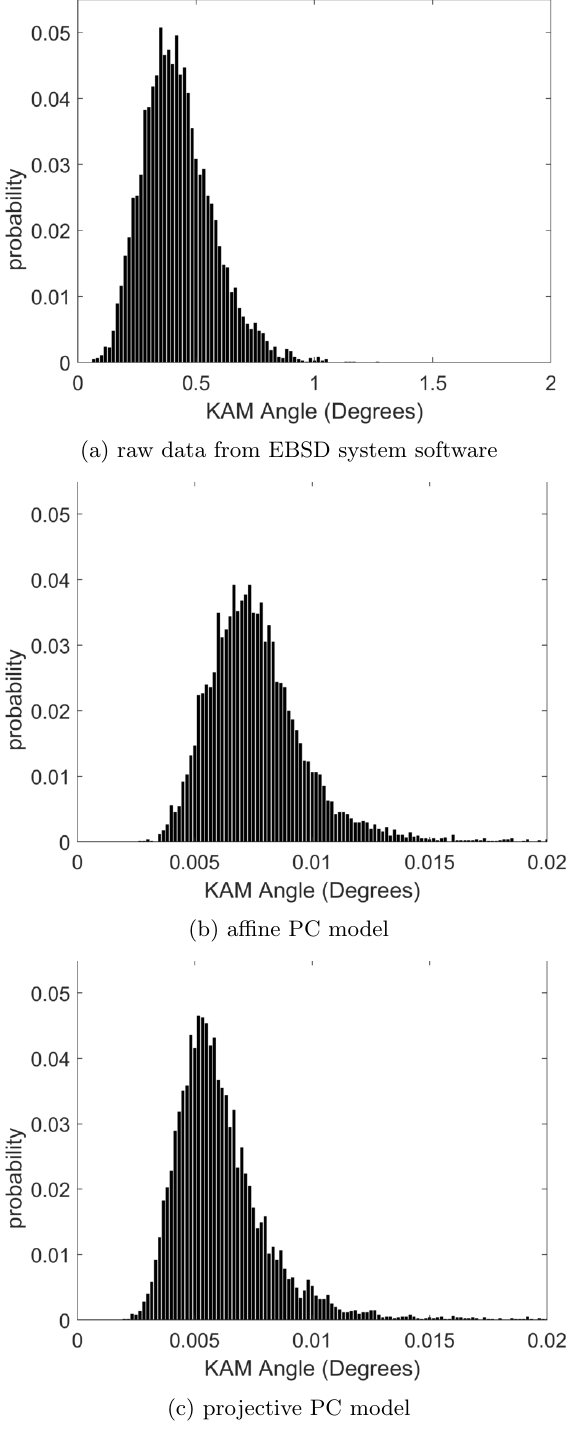
Figure 4. Histograms of the Kernel Average Misorientation angle for the orientation maps resulting from different analysis approaches. ( a ) raw data from EBSD system, ( b ) refined orientations using affine PC calibration, ( c ) refined orientations using projective PC calibration. Note that the x -axis limit in the top panel ( a ) is larger by a factor of 100 compared to the other two